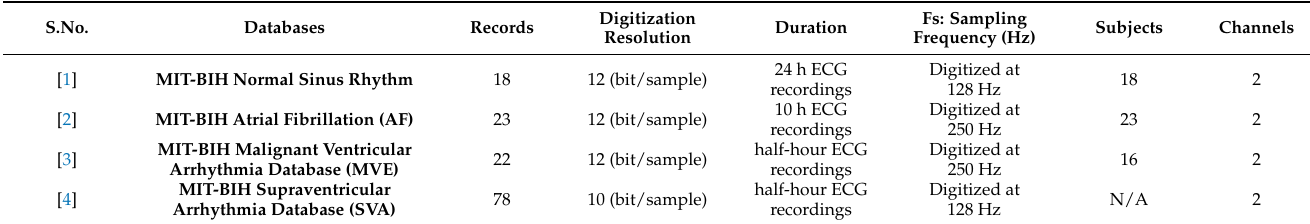
Table 1. Database specification [44].